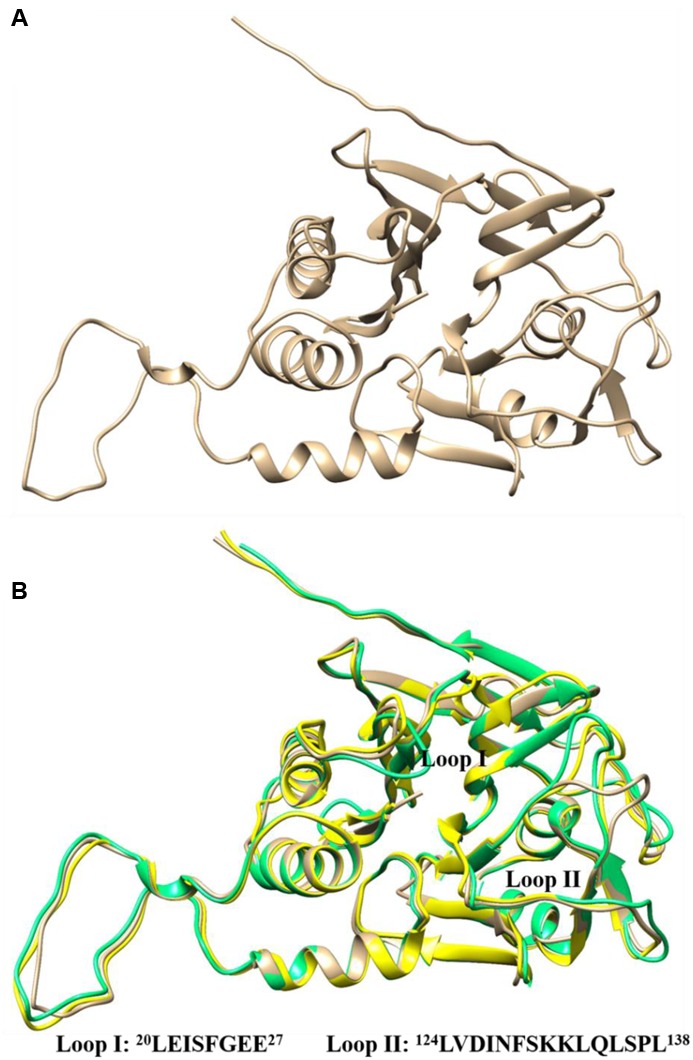
Three-dimensional structure of LgBSH predicted by homology modeling using Enterococcus faecalis BSH (4WL3) as template (A). Three-dimensional superimposed structures of LgBSH (tan) with their closest homology structures EfBSH (4WL3) (yellow) and LsBSH (5HKE) (spring green) using UCSF-Chimera. The sequences of loops (I and II) present in the substrate-binding pockets were represented in the figure (B).